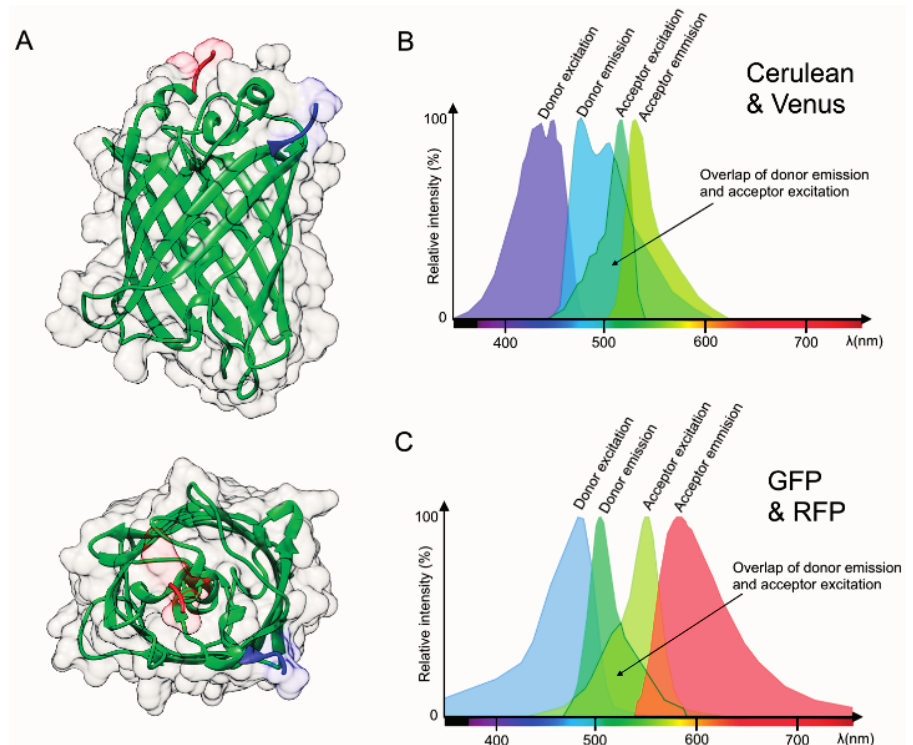
Figure 2. Structure and spectrum of fluorescent proteins. ( A ) The three-dimensional structure of Green fluorescent Protein (GFP) as it occurs naturally in the jellyfish species Aequorea Victoria [5]; ( B , C ) The spectrum of the fluorescent protein FRET-pair; (B) Cerulean (a cyan FP) and Venus (a yellow FP); and (C) GFP and RFP, also showing the overlap between donor emission and acceptor excitation, which is an important factor for the usability of a